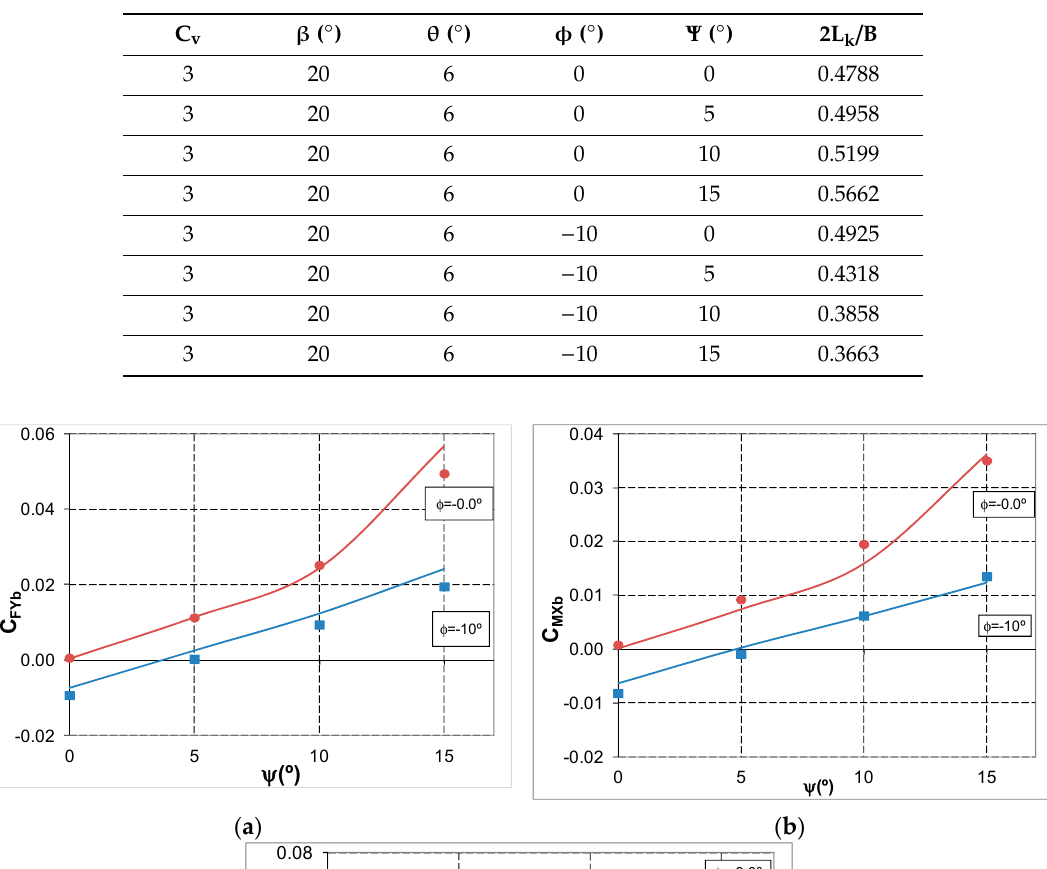
Table 2. Experimental conditions by Brown and Klosinsky [28].